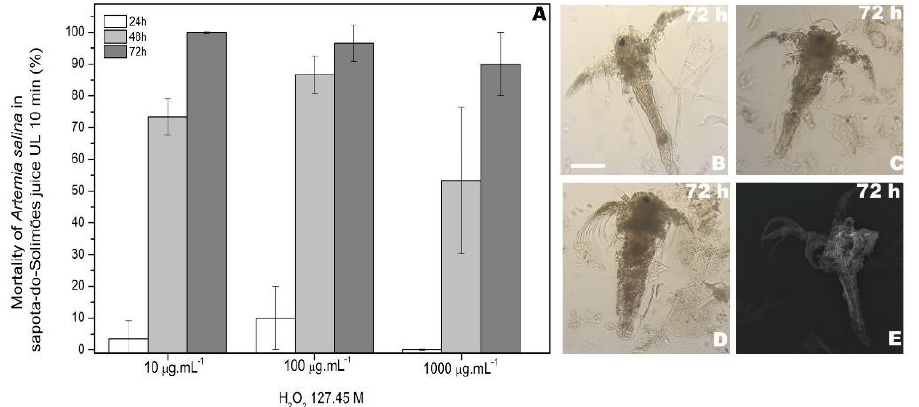
Figure 7. Protective effect of ultrasound-processed sapota-do-Solim õ es juice (UL10) in the 24/48/72 h interval against H 2 O 2 using Artemia salina nauplii ( A ). Morphological changes in the Artemia salina nauplii after 72 h of exposure under optical microscopy ultrasound-processed sapota-do-Solim õ es juice 10 min (UL10) 10 µ g · mL − 1 ( B ), ultrasound-processed sapota-do-Solim õ es juice 10 min (UL2) 100 µ g · mL − 1 ( C ), ultrasound-processed sapota-do-Solim õ es juice 10 min (UL10) 1000 µ g · mL − 1 ( D ). Morphological changes in the Artemia salina nauplii by scanning electron microscopy ultrasound- processed sapota-do-Solim õ es juice 10 min (UL10) 1000 µ g · mL − 1 ( E ). Bars, 200 µ